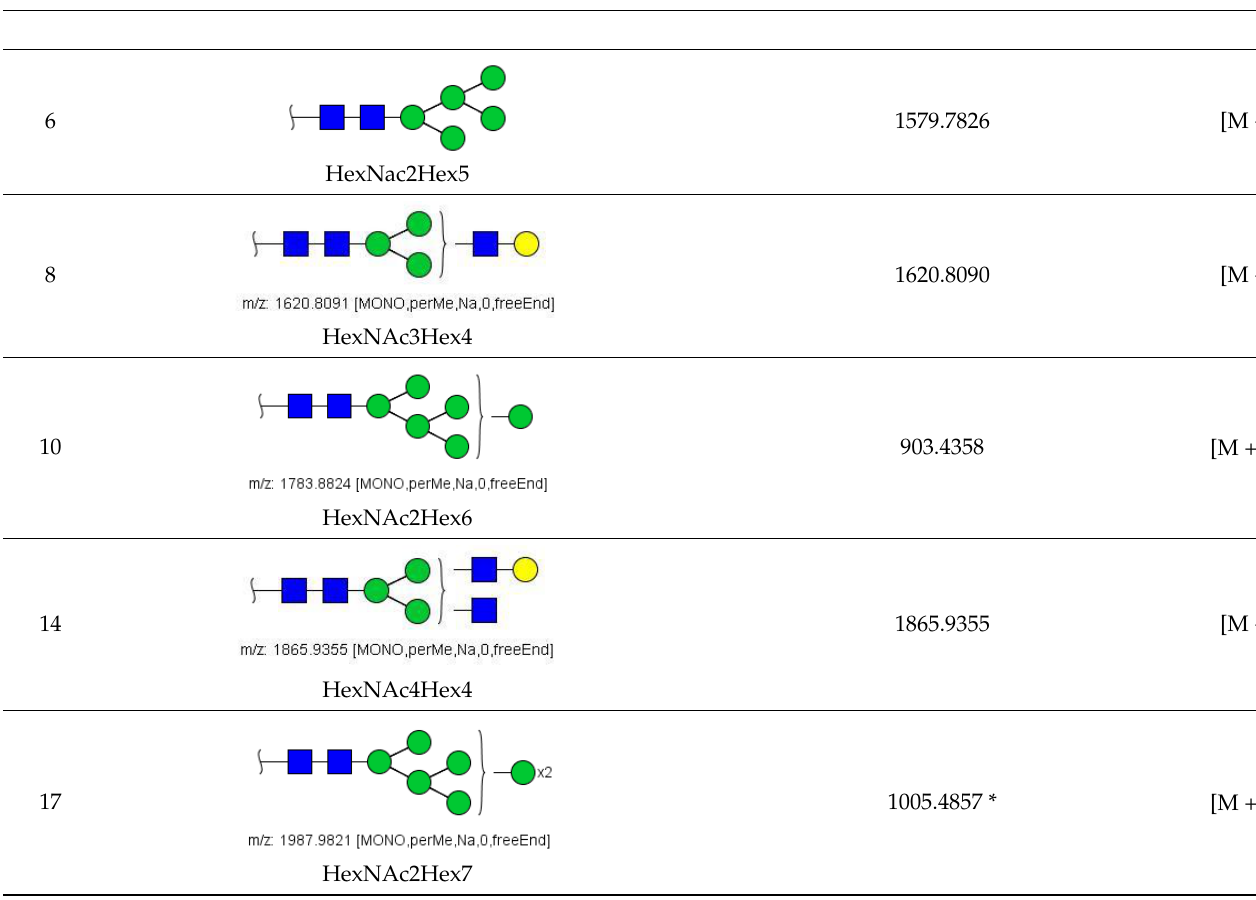
Table 2. N-glycan number, structure, accurate mass, mass used for quantification, corresponding adduct, and the heavy reference number used for LC-MS/MS and MALDI-TOF/MS quantification methods. Nr.